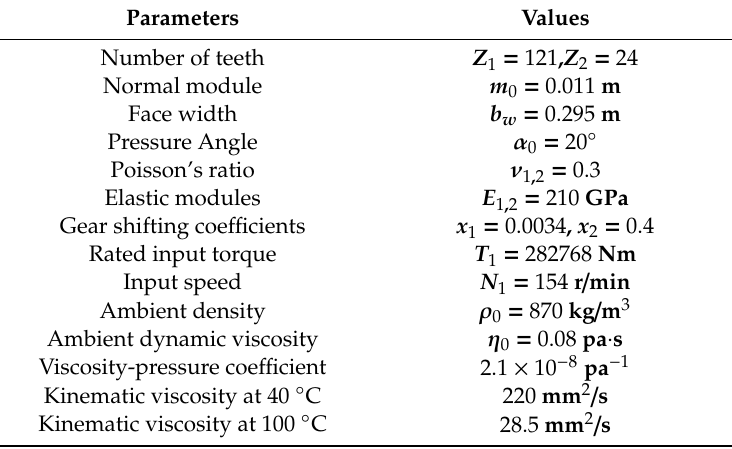
Table 1. Gear and lubricant parameters.